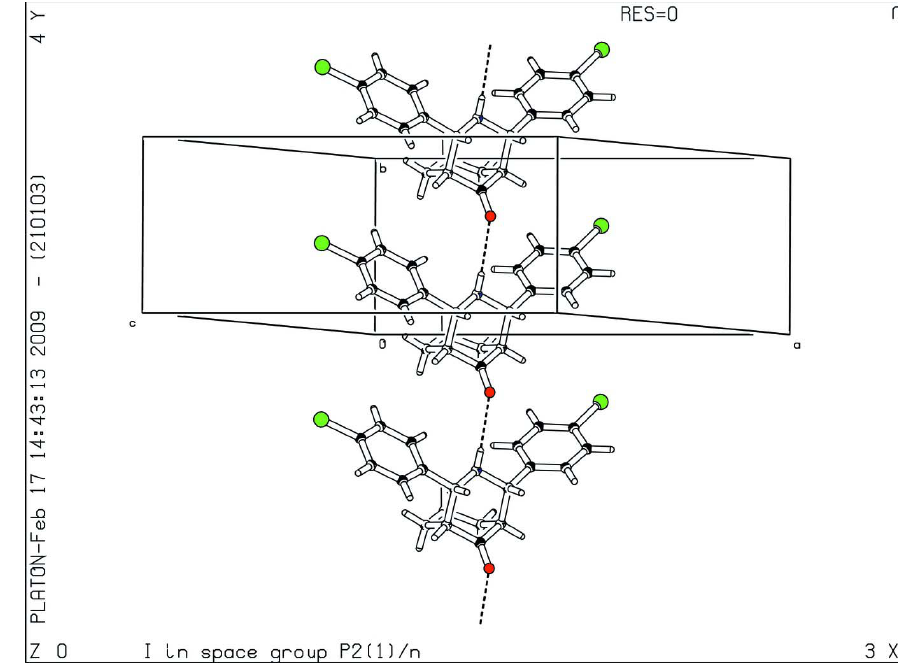
Figure 2 Packing of molecules via N-H..O